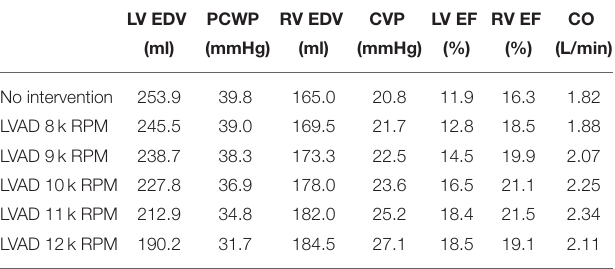
TABLE 2 | Functional metrics in the left and right ventricles.